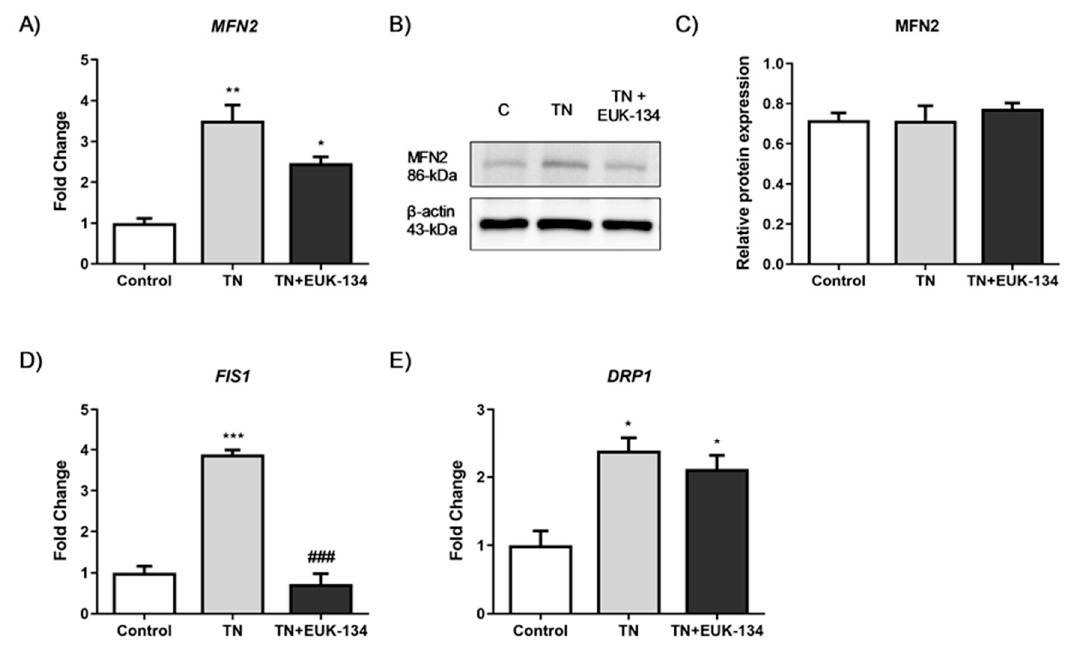
Figure 6. Mitochondrial dynamics of tunicamycin-treated cells with or without EUK-134. ( A ) Relative fold changes in mRNA expression of MFN2 fusion-associated gene. Data represent the mean fold change normalised to 18S housekeeper gene ± SEM of ∆ Ct values ( n = 3). * p ≤ 0.033, ** p < 0.002 against vehicle control or tunicamycin alone (#). ( B , C ) Cropped representative Western blot image and quantification of MFN2 protein levels relative to β -actin (loading control). Data represent the mean ± SEM ( n = 3). ( D , E ) Relative fold changes in mRNA expression of FIS1 and DRP1 fission-associated gene. Data represent the mean fold change normalised to 18S housekeeper gene ± SEM of ∆ Ct values ( n = 3). * p ≤ 0.033, ** p < 0.002, and *** p < 0.001 against vehicle control or tunicamycin alone (#).